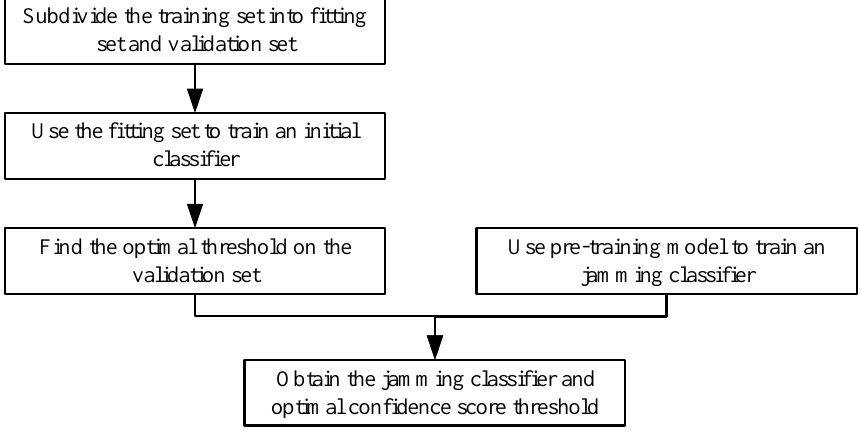
Figure 9. The training process of OSR model based on confidence score.